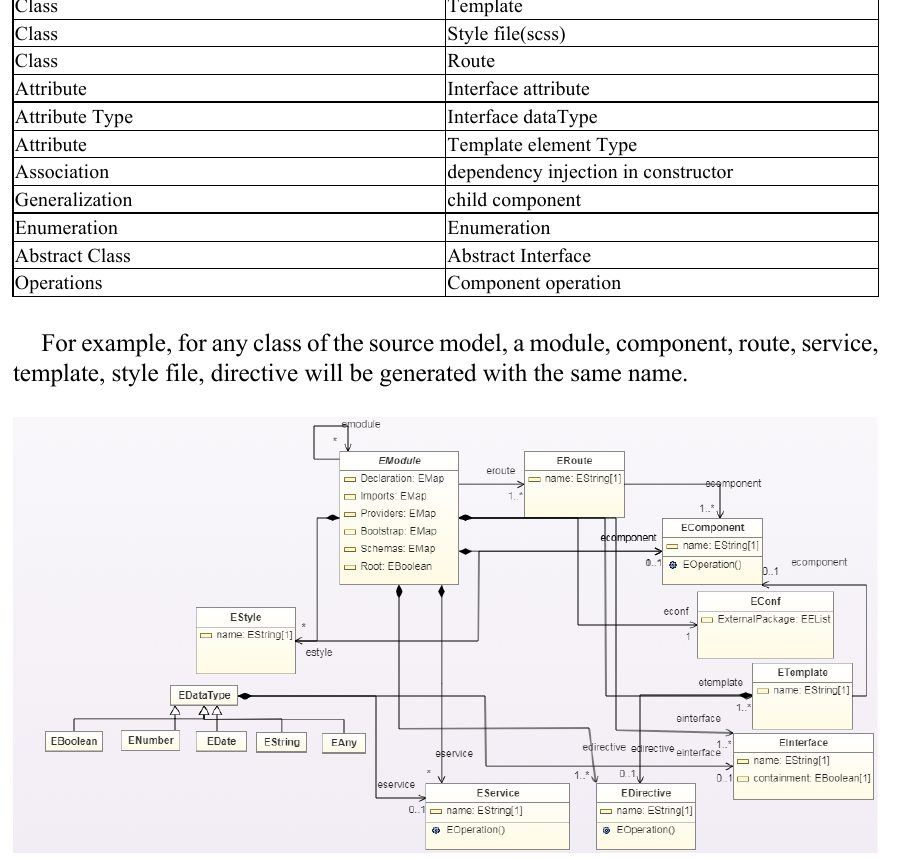
Fig. 4. Our proposed target